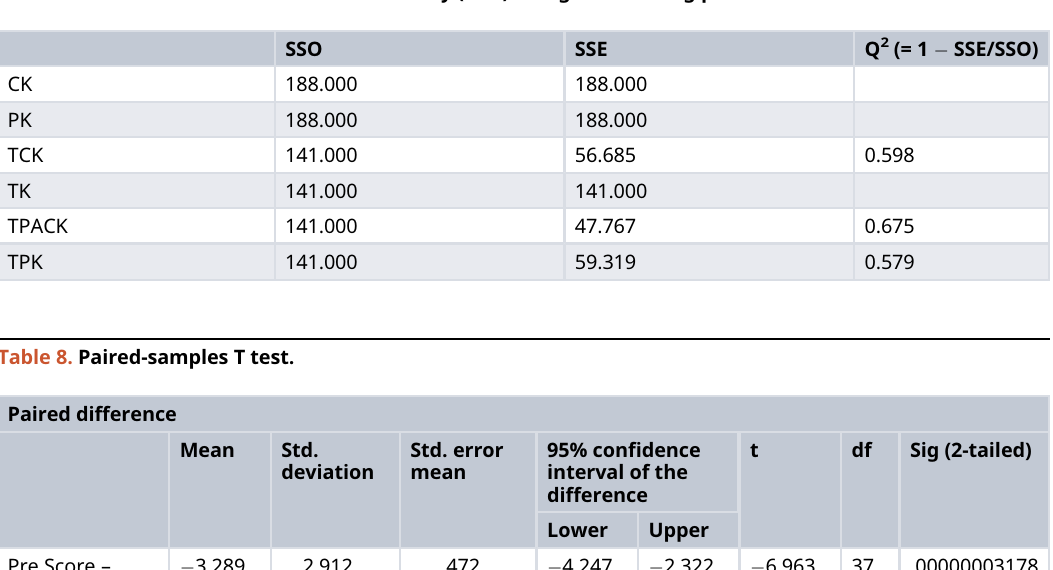
Table 7. Construct cross-validated redundancy (CVR) Using blindfolding procedure.